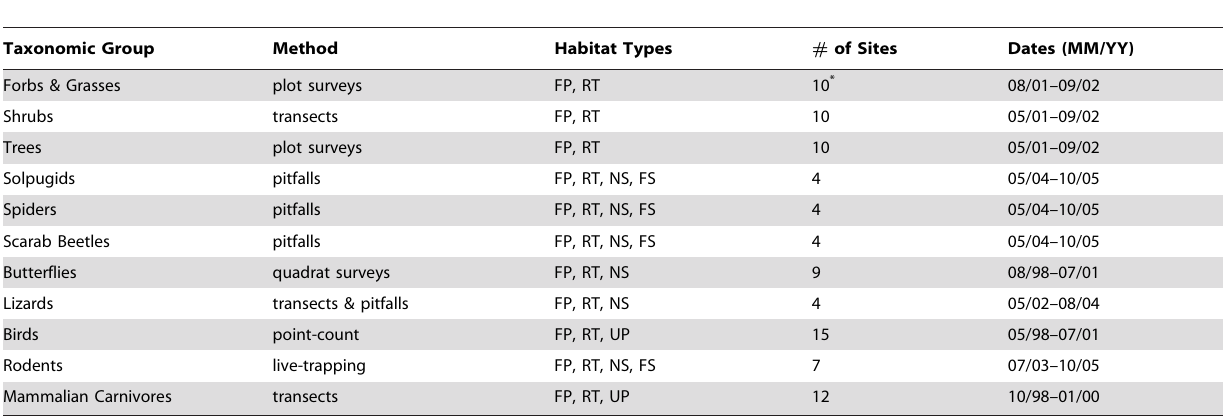
Table 1. Overview of survey methods, habitat types sampled, number of sites sampled, and sampling dates for the eleven taxonomic groups discussed in this